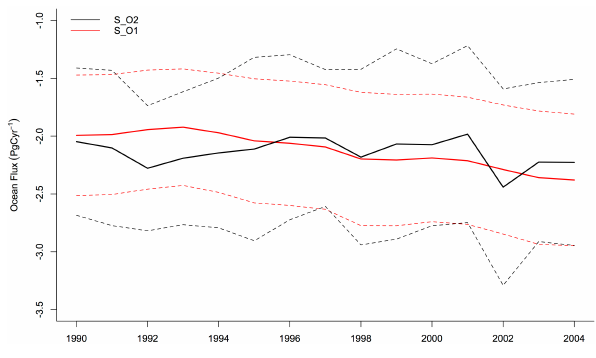
Figure 4. Global trends in ensemble ocean model fluxes. Black line: results from simulation S_O2 with variable “climate” and increas- ing CO 2 . Red line: results from simulation S_O1 with constant “cli- mate” and increasing CO 2 . The dashed grey and dashed red lines indicate the ± uncertainty bands given by the four models that con- tribute to the ensemble